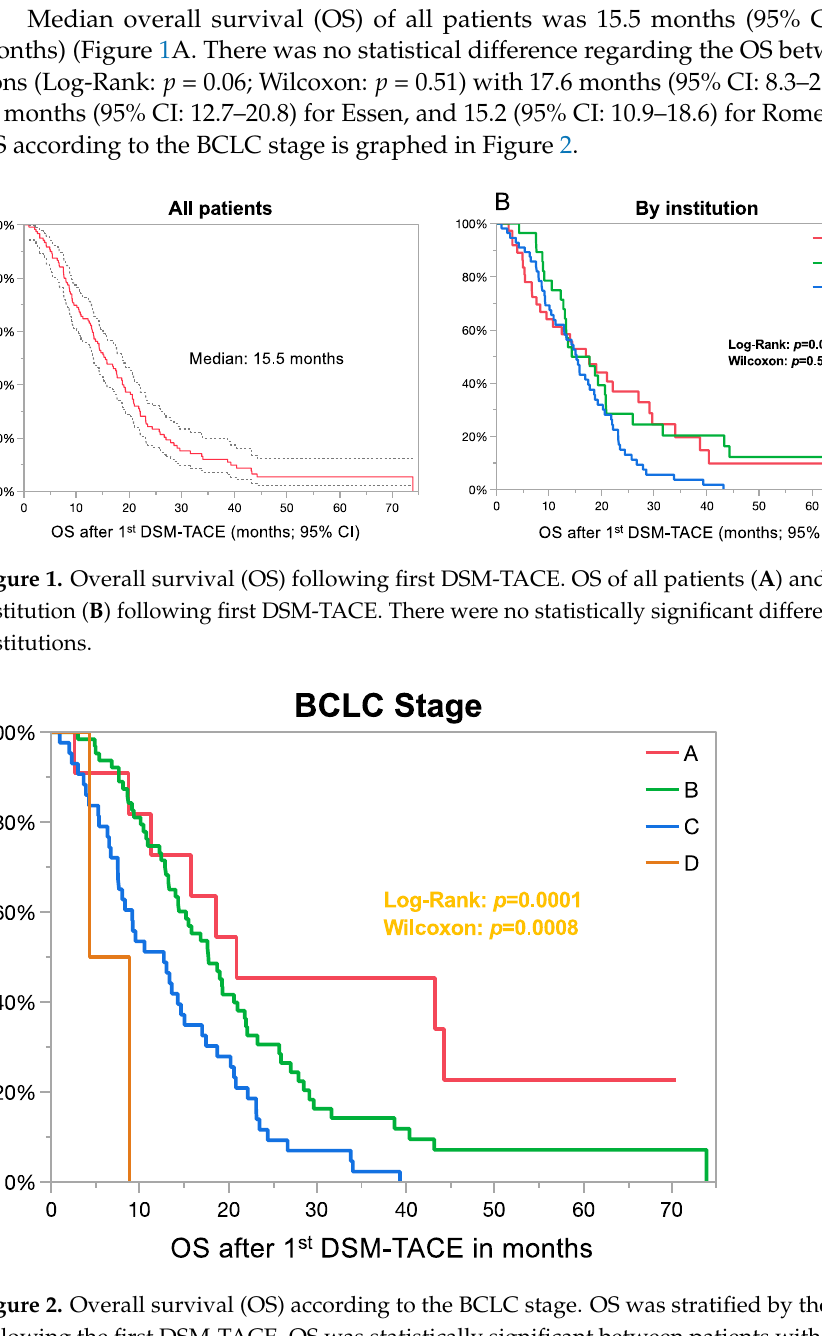
Figure 2. Overall survival (OS) according to the BCLC stage. OS was stratified by the BCLC stage following the first DSM-TACE. OS was statistically significant between patients with BCLC stages B and C ( p = 0.003). Differences between A and B ( p = 0.1) or between C and D ( p = 0.1) were not statistically